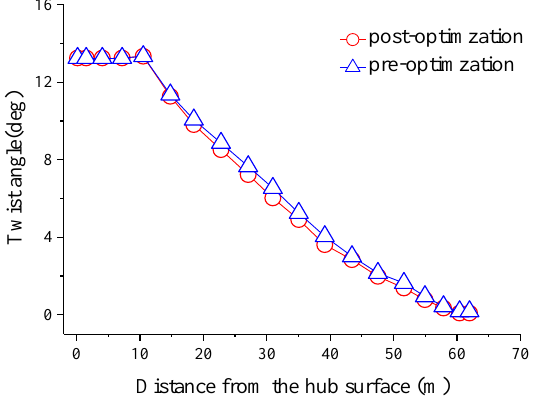
Figure 23. Distribution of the twist angle under actual sea conditions before and after optimization.